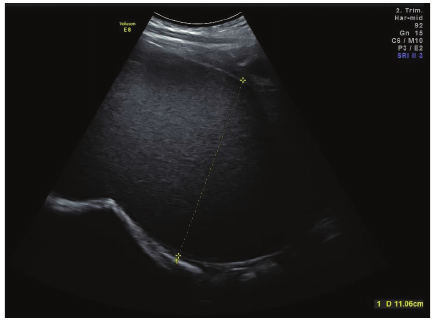
Figure 2: 2D ultrasound imaging of megahematocolpos.